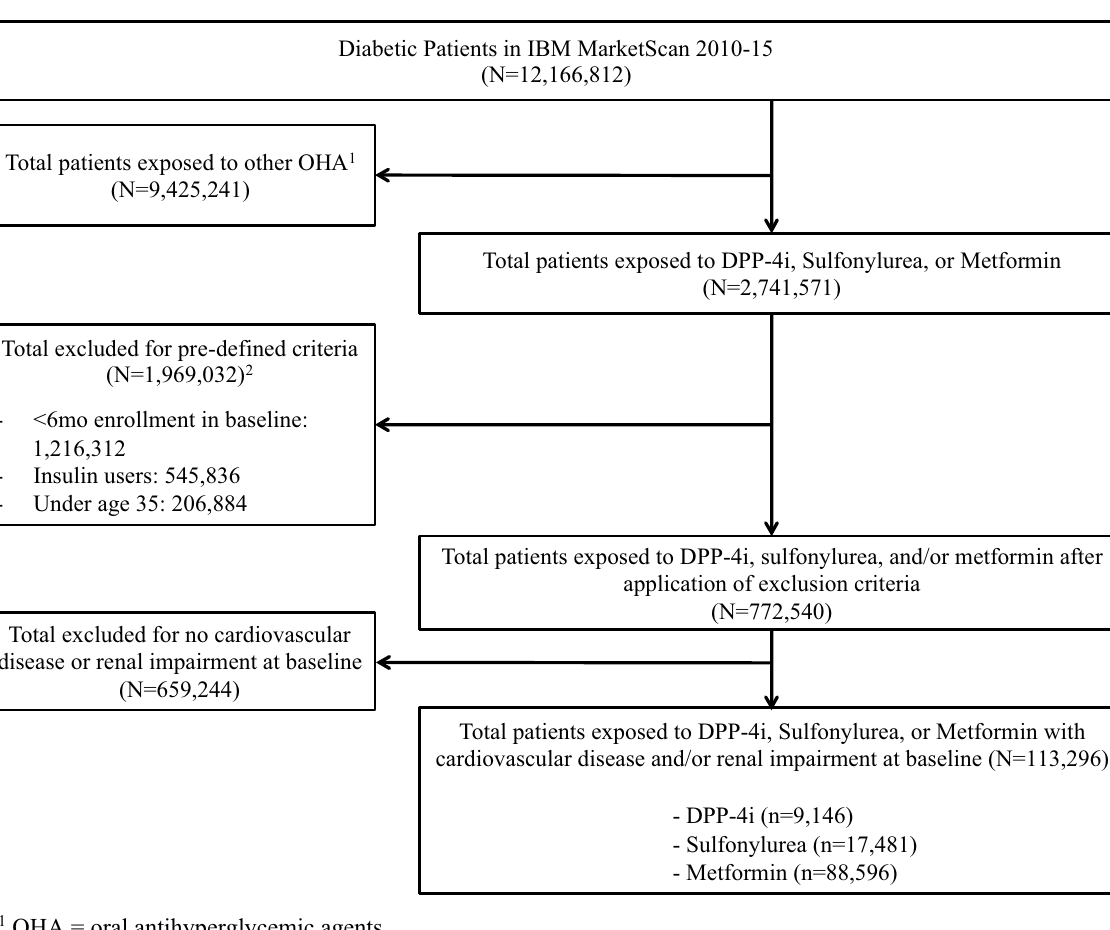
Figure 1. Cohort derivation and sample attrition after applying inclusion and exclusion criteria for retrospective